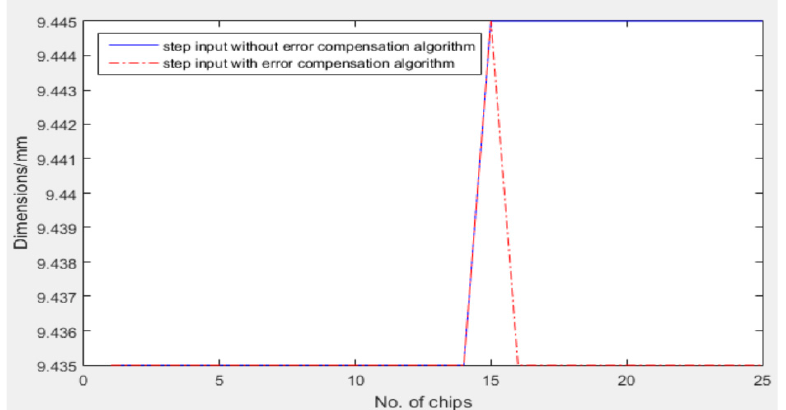
Figure 5. Step response of dimension compensation system.